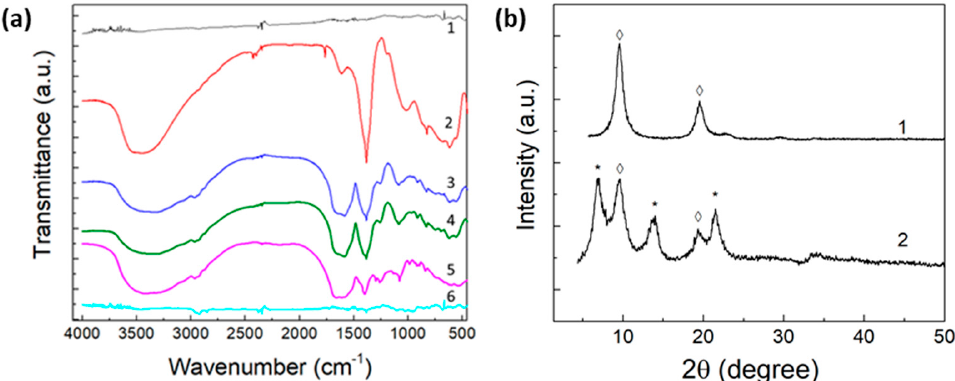
Figure 3. ( a ) FTIR spectra in KBr pellets: (1) pristine KBr, (2) LDH, wet with phosphate buffer and dried, (3) LDH + catalase mixture, wet with phosphate buffer and dried, (4) LDH + catalase + glutaraldehyde mixture, wet with phosphate buffer and dried, (5) pristine catalase enzyme, wet with phosphate buffer and dried, and (6) pristine glutaraldehyde. ( b ) X-ray diffraction patterns of (1) LDH as grown, wet with phosphate buffer and dried, and (2) LDH + catalase, wet with phosphate buffer and dried. The main basal reflections of the pristine (Zn–Al–NO 3 ) LDH phase and of the (Zn– Al–NO 3 ) LDH phase after interaction with catalase are labelled by diamonds ( ◊ ) and stars ( ⋆ ), respectively.